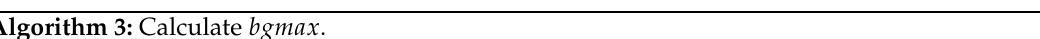
Algorithm 3: Calculate bgmax